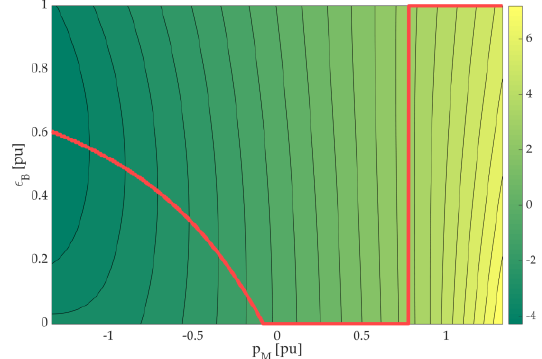
ε M , B ) plane and optimal ( p M ,